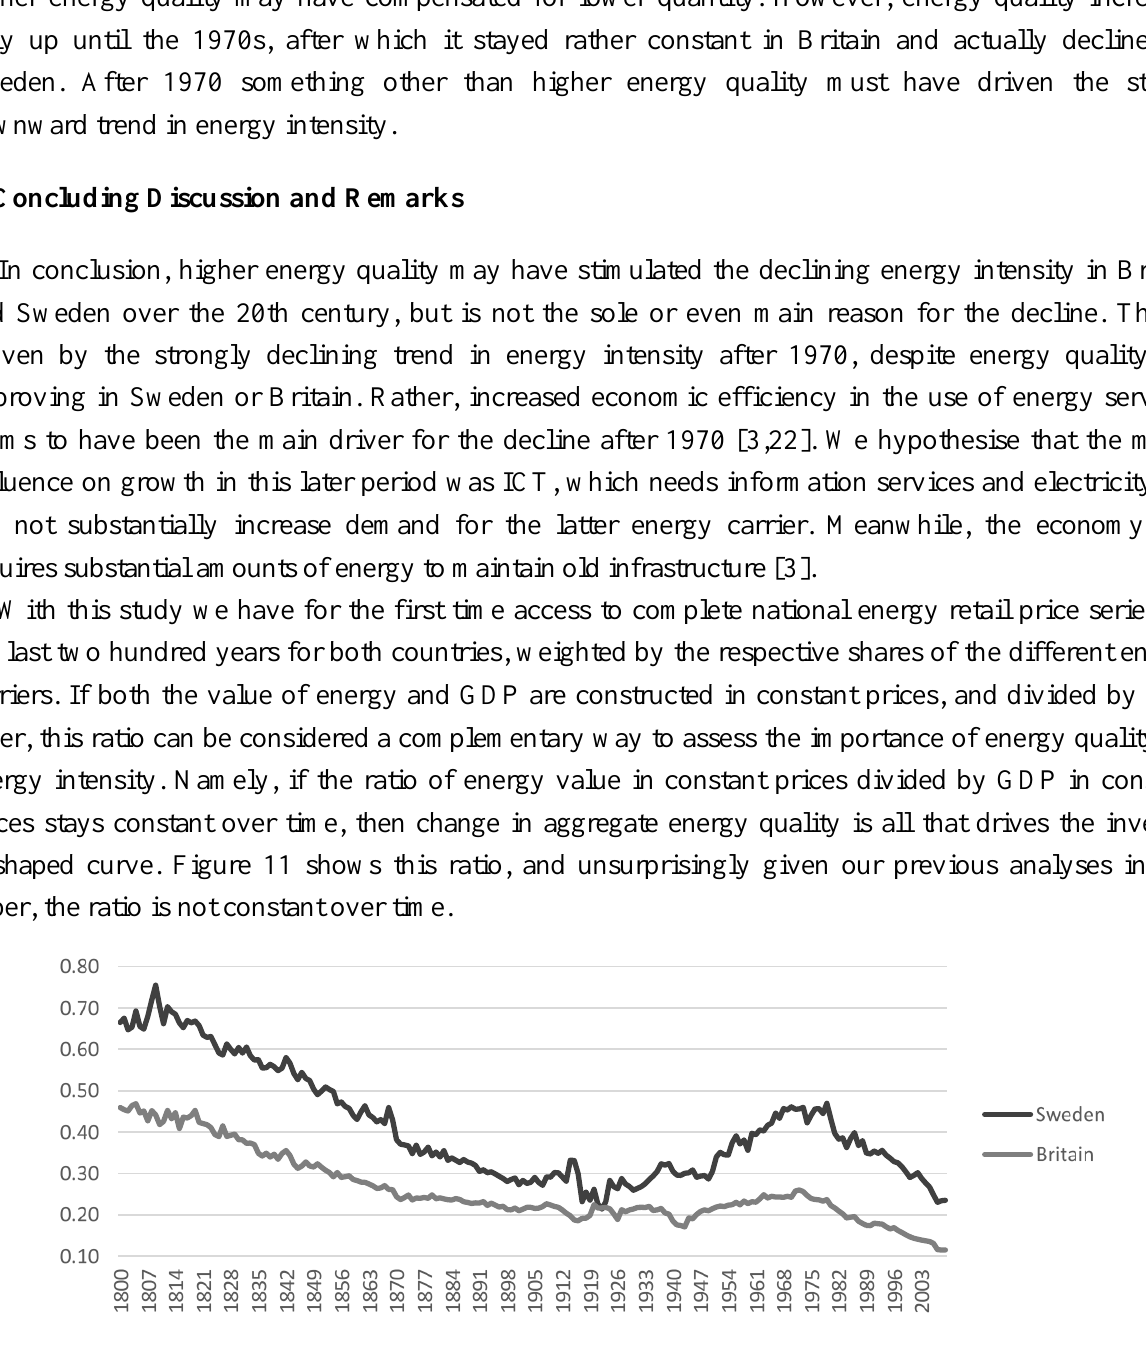
Figure 11. Energy value in constant prices divided by GDP in constant prices, 1900 price level year, for Britain and